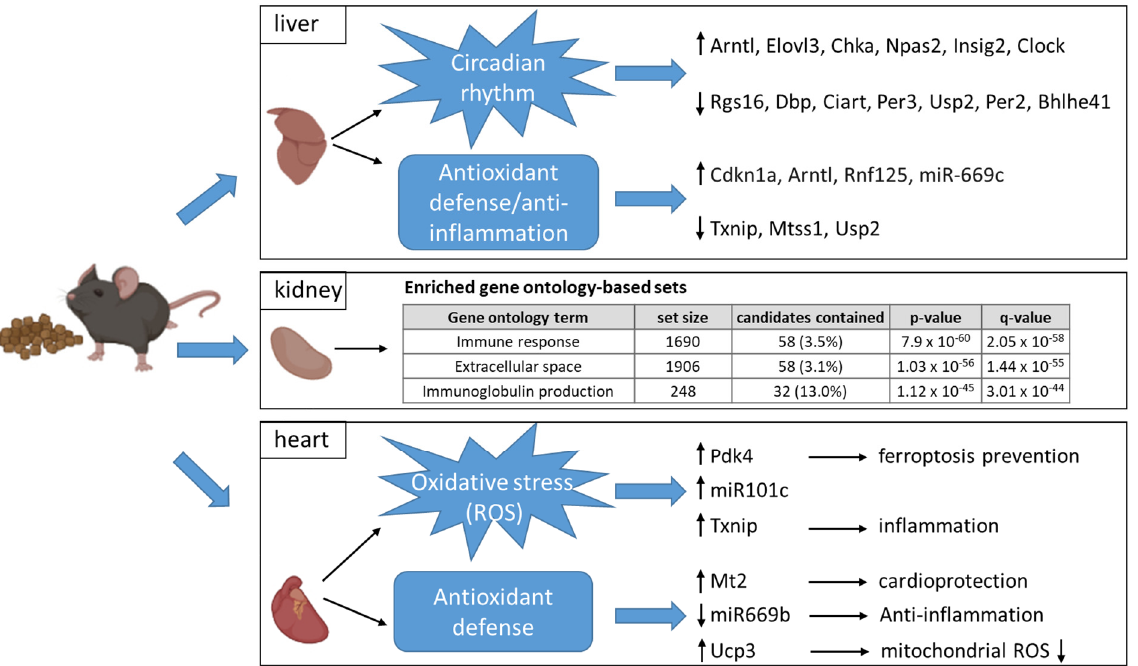
Figure 6. Affected genes in the heart of BC- vs. control-fed mice. ( a ) Significantly up-regulated and down-regulated genes (highlighted in grey) after 2 days BC-fed mice compared to control-fed mice (up-regulated > 2.0; down-regulated < − 2.0). ( b ) Significantly down-regulated genes after 8 days BC- fed mice compared to control-fed mice (down-regulated < − 2.0). ( c ) Significantly up-regulated genes after 8 days BC-fed mice compared to control-fed mice (up-regulated > 2.0). Noncoding RNAs and pseudogenes are not included.